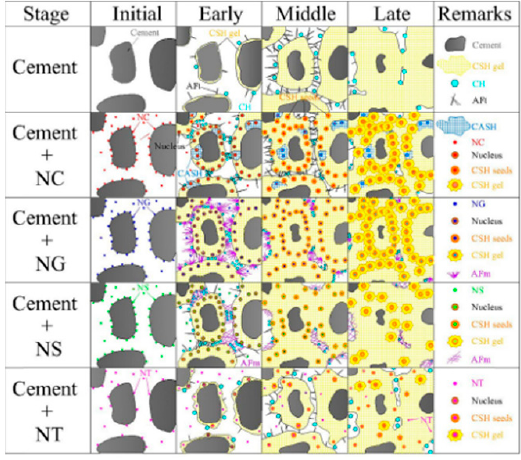
Figure 3. Hydration model for different nanomaterials [43].